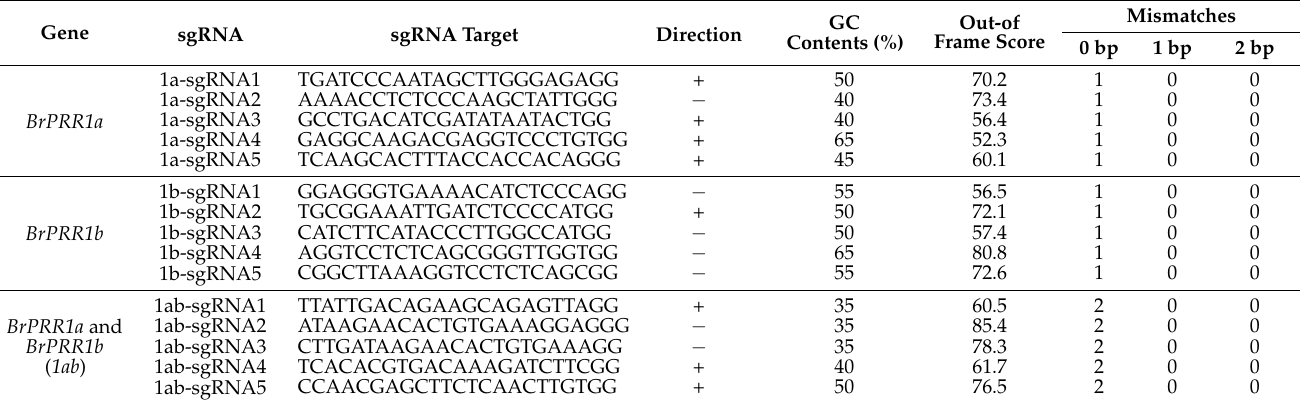
Table 1. List of selected sgRNAs targeting the BrPRR1a and BrPRR1b genes and potential off-target sites in the B. rapa genome, determined using CRISPR RGEN tools (http://www.regenome.net/cas- designer/ accessed on 15 January 2021).